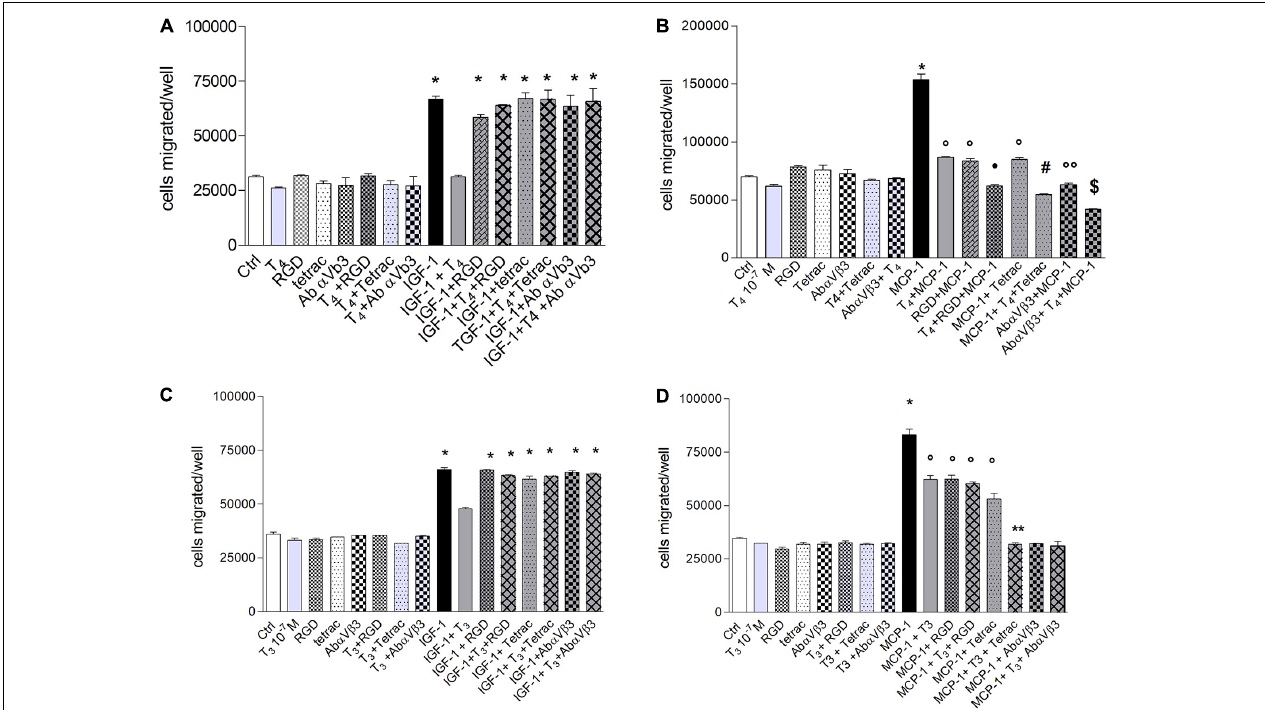
FIGURE 3 | (A) Effect of T 4 (100 nM), RGD, tetrac, and Ab α v β 3 on the migration of THP-1 cells, induced by insulin-like growth factor-1 (IGF-1). RGD (10 µ M), tetrac (10 µ M), and Ab- α v β 3 (8 µ g/ml) were preincubated 20 min before adding T 4 (100 nM) and IGF-1 (10 − 8 M). Results are reported as mean ± SD of n = 3 different experiments carried out in duplicate. * p < 0.001 vs. all. (B) Effect of T 4 (100 nM), RGD, tetrac, and Ab- α v β 3 on the migration of THP-1 cells, induced by monocyte chemoattractant protein 1 (MCP-1). RGD (10 µ M), tetrac (10 µ M), and Ab- α v β 3 (8 µ g/ml) were preincubated 20 min before adding T 4 (100 nM) and MCP-1 (100 ng/ml). Results are reported as mean ± SD of n = 4 different experiments carried out in duplicate. * p < 0.001 vs. all; ◦ p < 0.05 vs. Ctrl; • p < 0.001 vs. MCP-1 + RGD; # p < 0.001 vs. MCP-1 + tetrac; ◦◦ p < 0.05 vs. MCP-1 + tetrac; § p < 0.01 vs. MCP-1 + Ab- α v β 3. (C) Effect of T 3 (100 nM), RGD, tetrac, and Ab- α v β 3 on the migration of THP-1 cells, induced by IGF-1. RGD (10 µ M), tetrac (10 µ M), and Ab- α v β 3 (8 µ g/ml) were preincubated 20 min before adding T 3 (100 nM) and IGF-1 (10 − 8 M). Results are reported as mean ± SD of n = 2 different experiments carried out in duplicate. * p < 0.001 vs. all. (D) Effect of T 3 (100 nM), RGD, tetrac, and Ab- α v β 3 on the migration of THP-1 cells, induced by MCP-1. RGD (10 µ M), tetrac (10 µ M), and Ab- α v β 3 (8 µ g/ml) were preincubated 20 min before adding T 3 (100 nM) and MCP-1 (100 ng/ml). Results are reported as mean ± SD of n = 4 different experiments carried out in duplicate. * p < 0.001 vs. all; ◦ p < 0.05 vs. Ctrl; ** p < 0.001 vs. MCP-1 + tetrac.